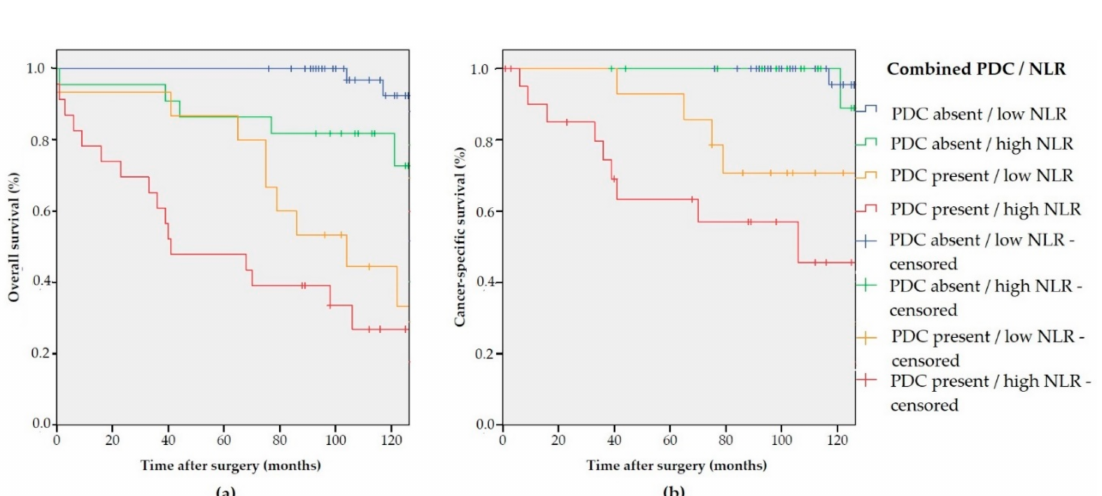
Figure 3. ( a ) Kaplan–Meier estimates of OS ( p < 0.001) according to the combined PDC/NLR variable; and ( b ) Kaplan–Meier estimates of CSS ( p < 0.001) according to the combined PDC/NLR